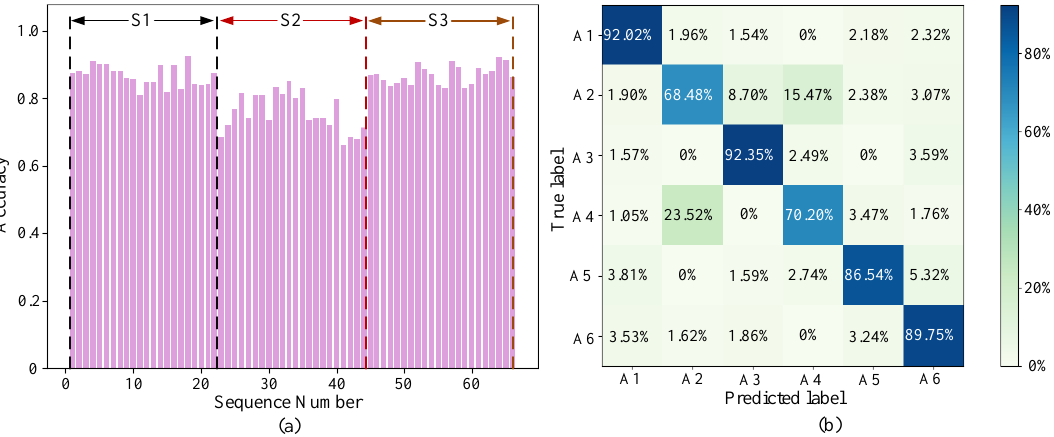
Figure 15. ( a ) The recognition accuracy and ( b ) confusion matrix of Uni-LSTM after multi-frequency